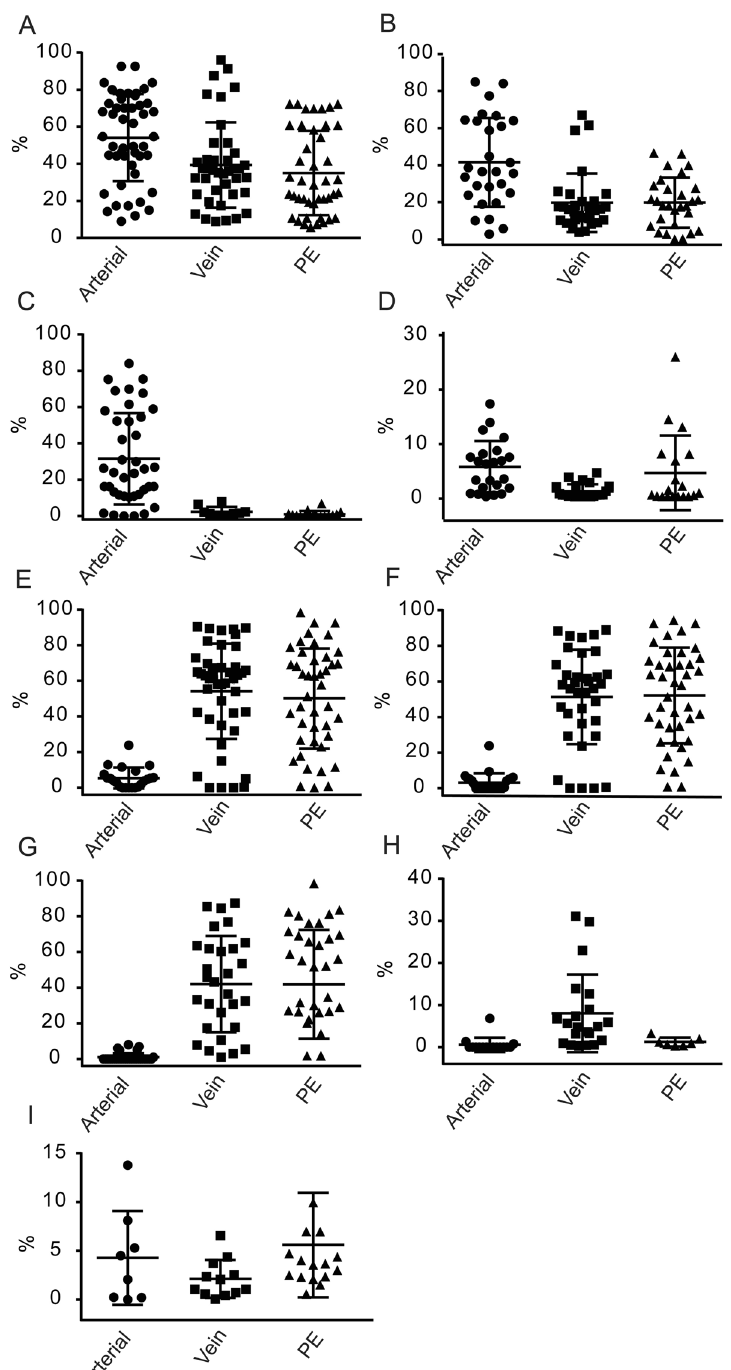
Figure 4. Quantitative analyses of structures (volume fraction, %) identified in pulmonary emboli, arterial and venous thrombi. Thrombi were visualized by scanning electron microscopy and their composition was quantified as described in the Materials and Methods section. The fibrin components, different shapes of erythrocytes as well as white blood cells, platelets and microvesicles were identified in thrombi and compared here as a percentage of the total thrombus volume. ( • ) – Arterial thrombi; ( ■ ) – Venous thrombi; ( ▲ ) – Pulmonary emboli. Quantitative differences were compared statistically by ANOVA test with Dunnett’s correction for multiple comparison. P values for differences between pulmonary emboli, venous and arterial thrombi are indicated by ** , and * . ( A ) Fibrin fibers; ** P = 0.0088, * P = 0.0408. ( B ) Fibrin bundles; ** P = 0.0035, * P = 0.035. ( C ) Polyhedrocyte-shaped erythrocytes; ** P < 0.0001, * P < 0.0001; ( D ) Platelets; ** P < 0.001, * P = 0.002; ( E ) Microvesicles; ** P = 0.048, * P = 0.010; ( F ) Echinocytes; ** P = 0.0260, * P = 0.0068; ( G ) Total red blood cells; ** P < 0.0001, * P < 0.0001; ( H ) Combination of polyhedrocytes and intermediate shapes of erythrocytes; ** P < 0.0001, * P < 0.0001.; ( I ) White blood cells; ** P = 0.0044, * P =